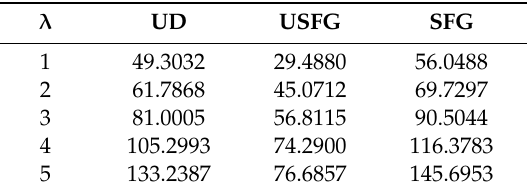
Table 14. First five natural frequencies for the FG-CNTRC rectangular plate with di ff erent distributions without the agglomeration e ff ect.